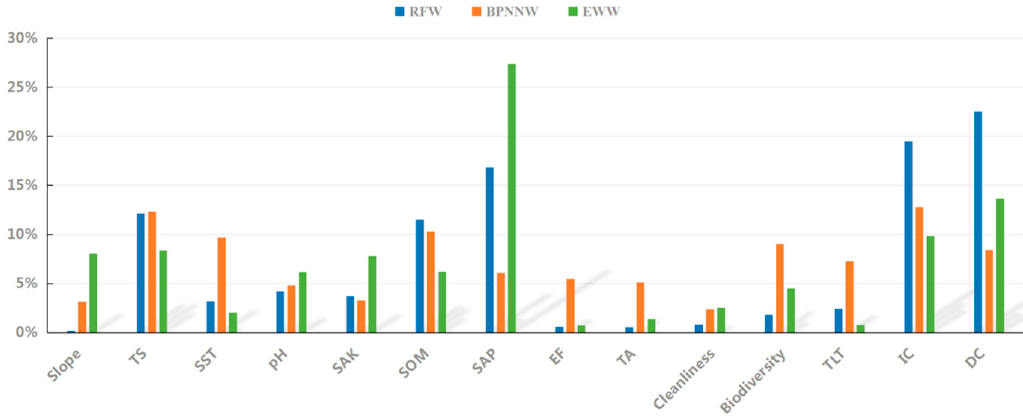
Figure 7. Indicator weights for the three assessment methods.